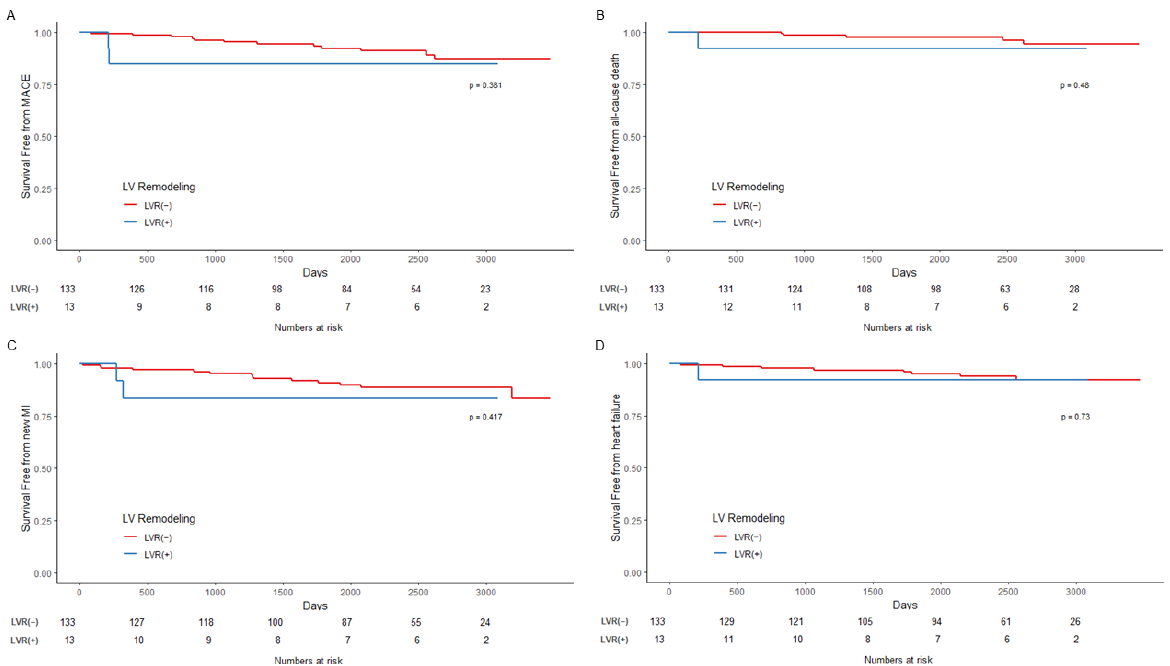
Figure 4. Kaplan – Meier curves for outcomes in patients who had complete revascularization. ( A ) Figure 4. Kaplan–Meier curves for outcomes in patients who had complete Composite outcome of all-cause death, myocardial infarction, and readmission due to heart fail-